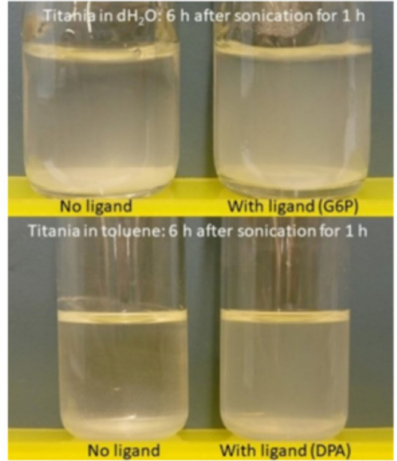
Figure A2. Titania sonicated in water or toluene compared with titania sonicated in the presence of ligands. The addition of ligands stabilizes the particles and less precipitation has occurred six hours after